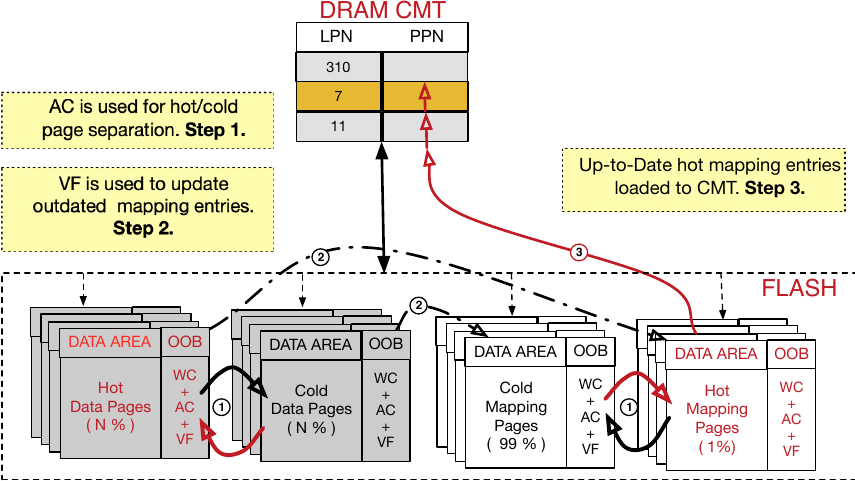
Figure 3. Schematic diagram of the proposed FTRM